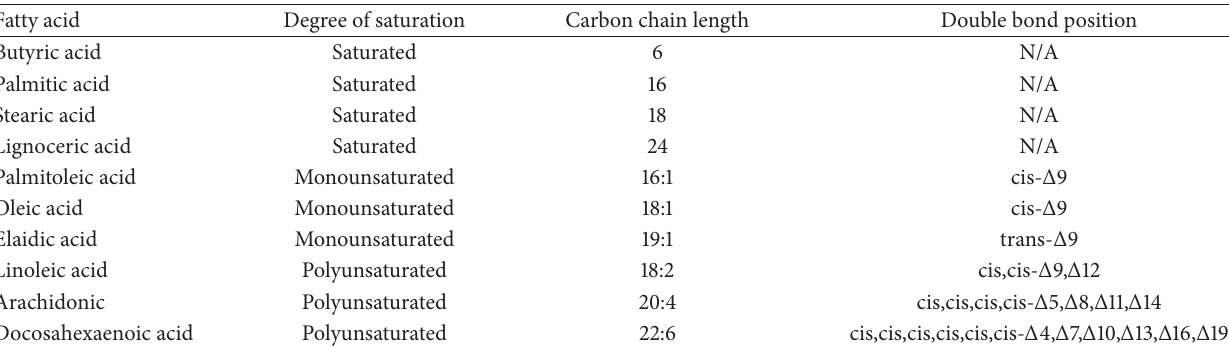
Figure 3: O-Palmitoylation of BSA. (a) The donated hydrogen from PA associates with Cl − to form HCl and two palmitate anions associate with Ca 2+ to form calcium palmitate. The negatively charged palmitate allows a nucleophilic attack on ethylchloroformate (EtOCOCL). The Cl − is removed as a leaving group and an activated palmitate (anhydride) is formed. DMF: dimethylformamide. (b) Available hydroxyl groups on BSA perform a nucleophilic attack on the activated palmitate via an SN2 mechanism. The leaving group is removed and the BSA is O- palmitoylated. (c) Chemical structures of elaidic acid and oleic acid. Table 3: Panel of fatty acids tested against anti-LCSFA